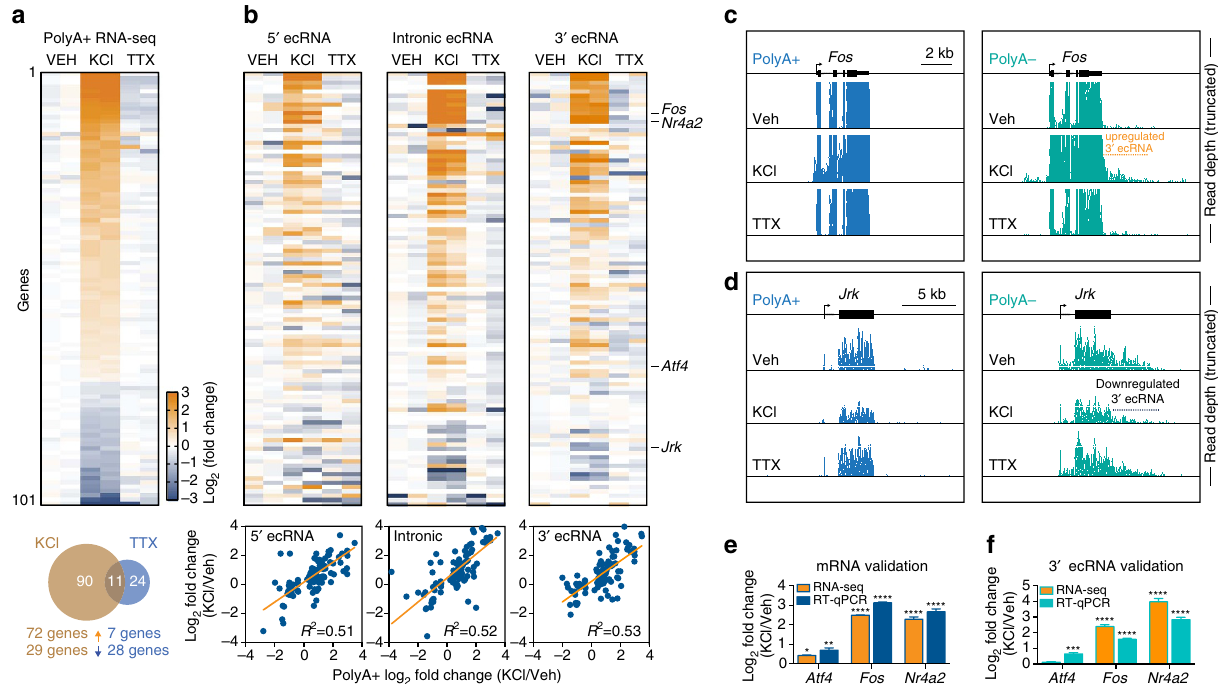
Figure 2 | Regulation of mRNA and ecRNA by neuronal activity. ( a ) PolyA þ RNA-seq following 1h neuronal depolarization (25mM KCl) or inactivation (1 m M TTX) reveals altered mRNA expression at a small subset of genes. Top, heatmap of KCl-altered transcripts (each column ¼ 1 biological replicate; 2 replicates per treatment). Bottom, Venn diagram of overlap between transcripts altered by KCl and TTX. ( b ) Corresponding heatmaps from PolyA (cid:2) RNA-seq reveal relationship between activity-related mRNA and ecRNA changes. PolyA (cid:2) RNA transcription from 5 0 , intronic and 3 0 sites all correlated significantly with mRNA changes following neuronal depolarization with KCl (linear regression, P o 0.0001 for each comparison). ( c , d ) Representative examples of activity-induced increases ( Fos gene, ( c )) and decreases ( Jrk gene, ( d )) in 3 0 ecRNA levels. RNA-seq reads shown individually; read depth truncated to highlight ecRNA changes. ( e , f ) Validation of RNA-seq results with RT-qPCR ( n ¼ 6 biological replicates) confirms changes in mRNA and ecRNA levels. Data are expressed as mean ± s.e.m. Individual comparisons made with Student’s t -test versus vehicle, * P o 0.05, ** P o 0.01, *** P o 0.001 and **** P o